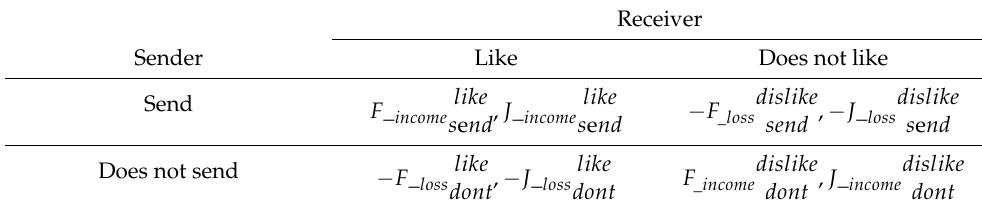
Table 2. The sender–receiver game matrix based on game